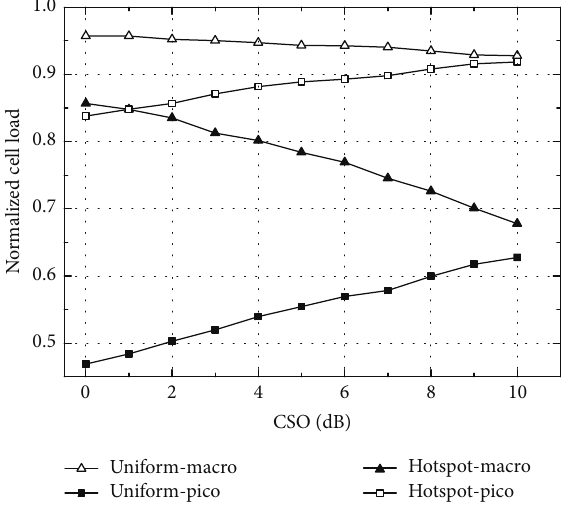
Figure 6: Cell load with different CSOs.